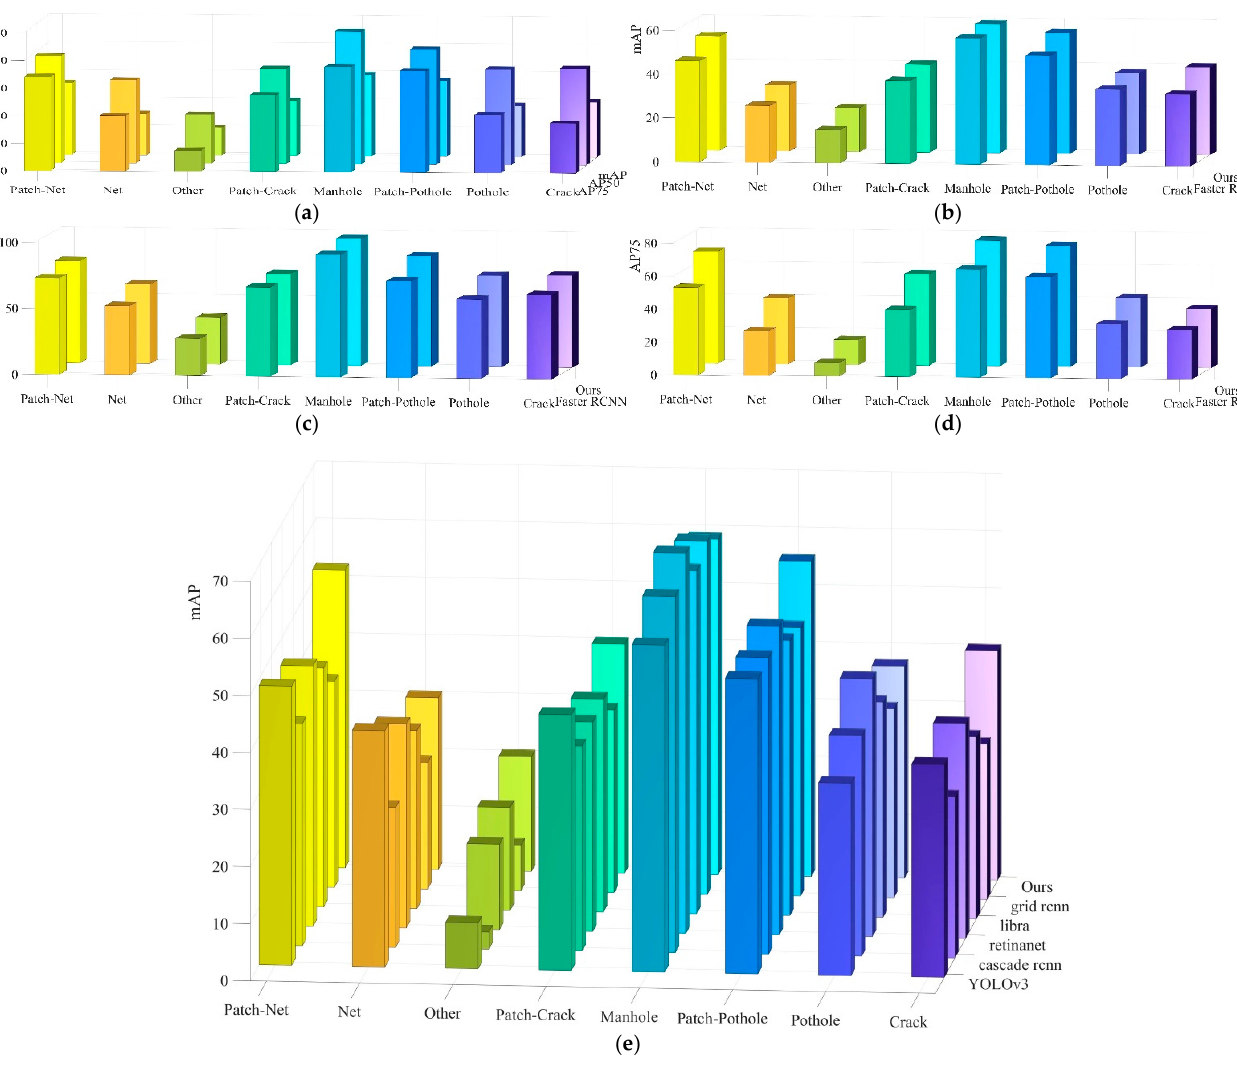
Figure 10. Class-wise performance. ( a ) is mAP, AP50, AP75 for DASNet on each disease category. ( b ) is mAP of DASNet and Faster RCNN in each disease category. ( c ) is AP50 of DASNet and Faster RCNN in each disease category. ( d ) is AP75 of DASNet and Faster RCNN in each disease category. ( e ) is the mAP of SOTA algorithms in each disease category.